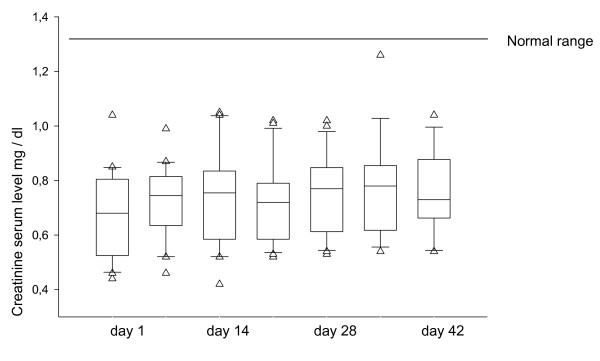
Boxplott of Creatinine serum levels. Day 1 after start of therapy to day 42.